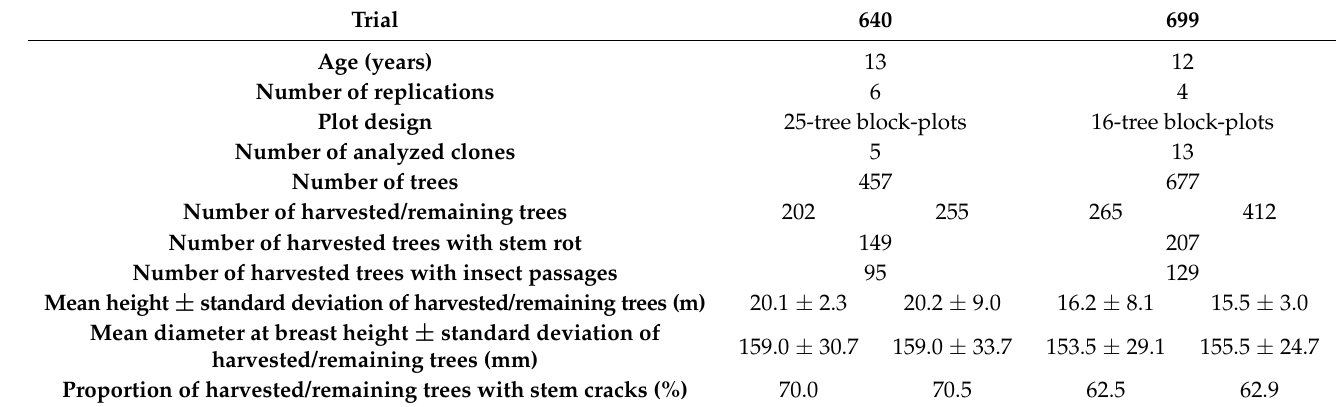
Table 1. Characteristics of the studied hybrid aspen clonal trials 640 and 699 in Central